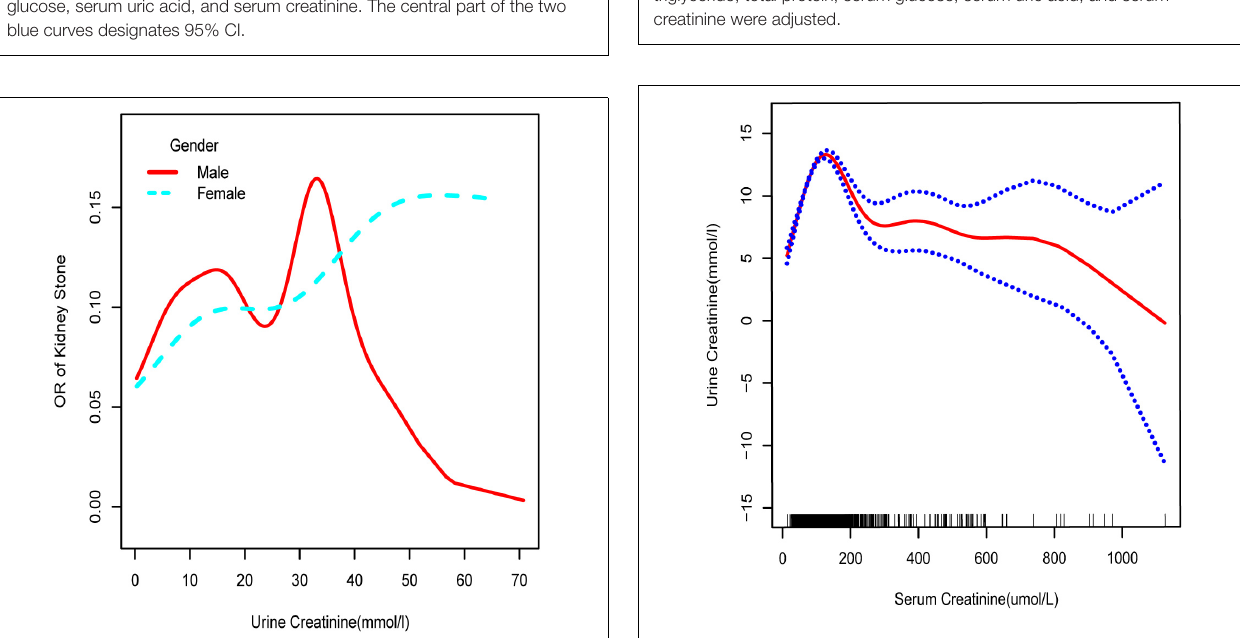
( Table 4 and Figure 1 ), men (inflection point: UCR 5.923